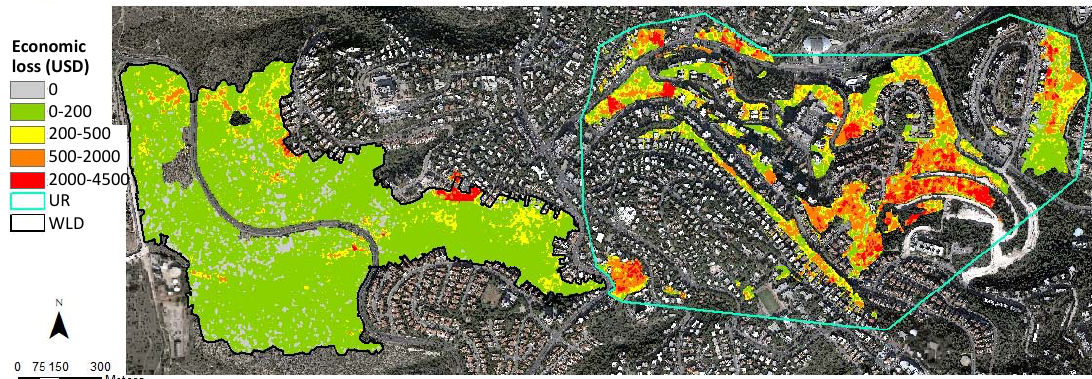
Figure 9. Map of spatially distributed economic damage caused to the trees by the fire in the WUI area. Estimations are in US dollars per (3 m) pixel.